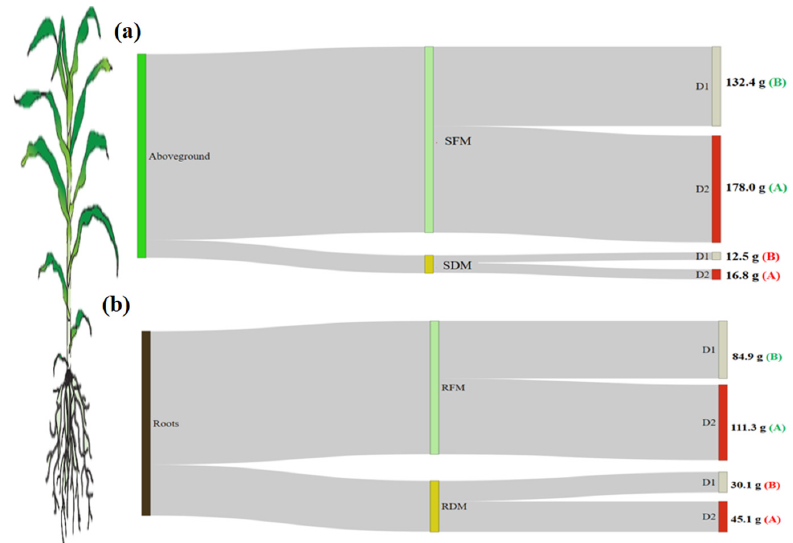
Figure 2. Aboveground and root mass of maize under different SMS doses at 70 DAS. SFM: shoot fresh matter and SDM: shoot dry matter (a), RFM: root fresh matter and RDM: root dry matter (b). Means followed by different uppercase letters for the same color differ according to the t-LSD test ( p > 0.05).